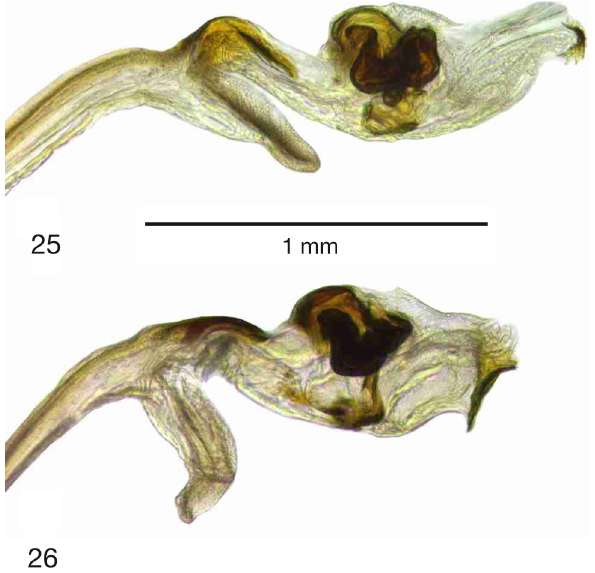
Figs 25–26. Ichneumonopsis spp., glans. 25 . I. burmensis Hardy, 1973. 26 . I. taiwanensis sp.